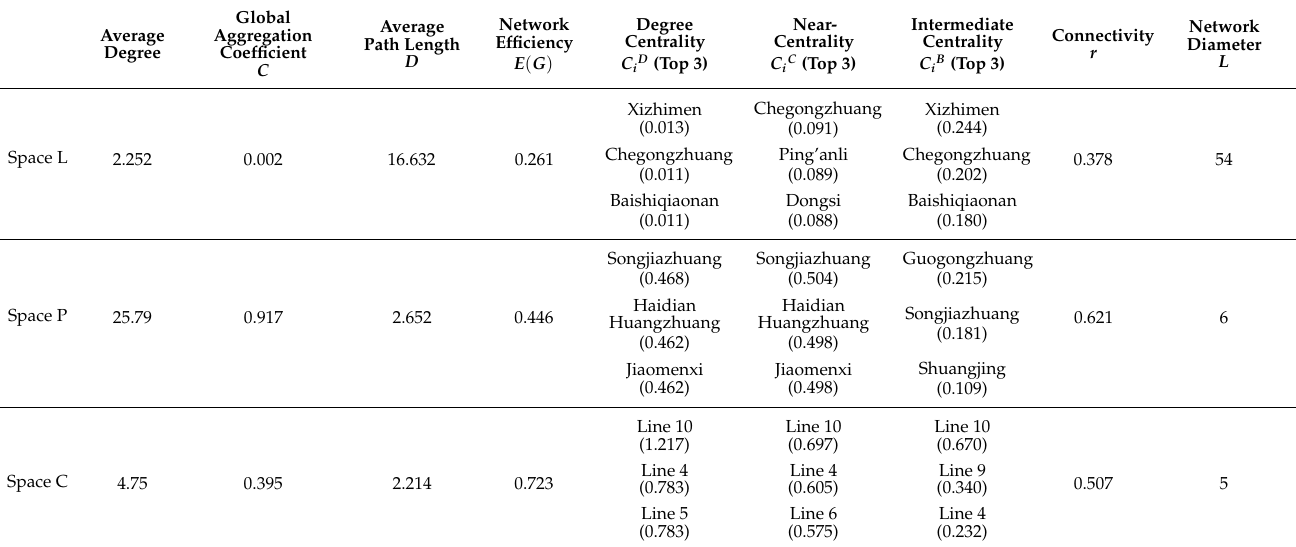
Table 3. Index parameter statistics of complex